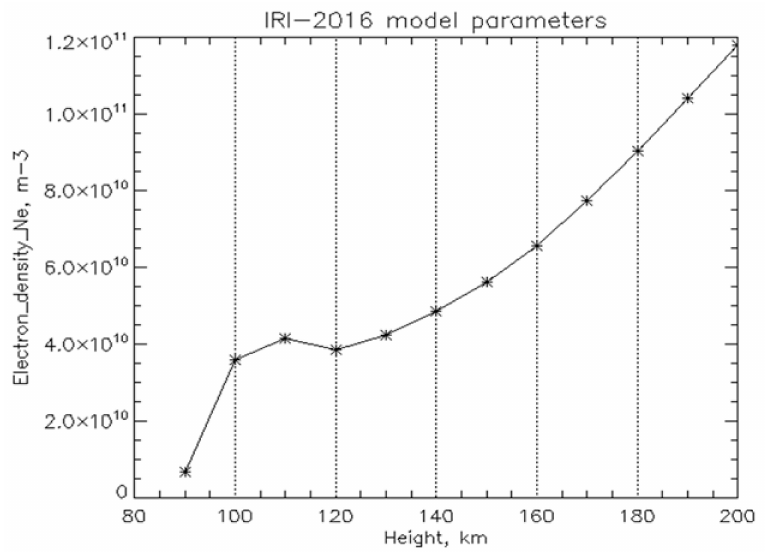
Figure 3. Electron density profile according to the IRI-2016 model on 26 May 2010 at 18:05